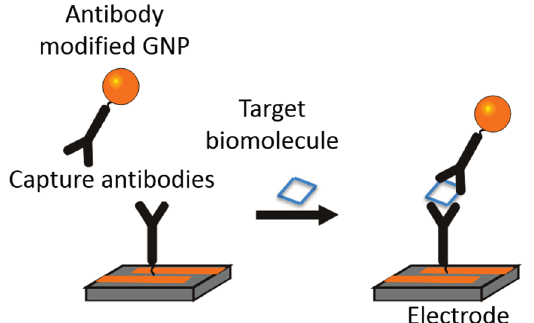
Figure 2. An example of the mechanism used for biomolecule detection. Here the target biomolecule allows for a connection between the modified GNP and electrode